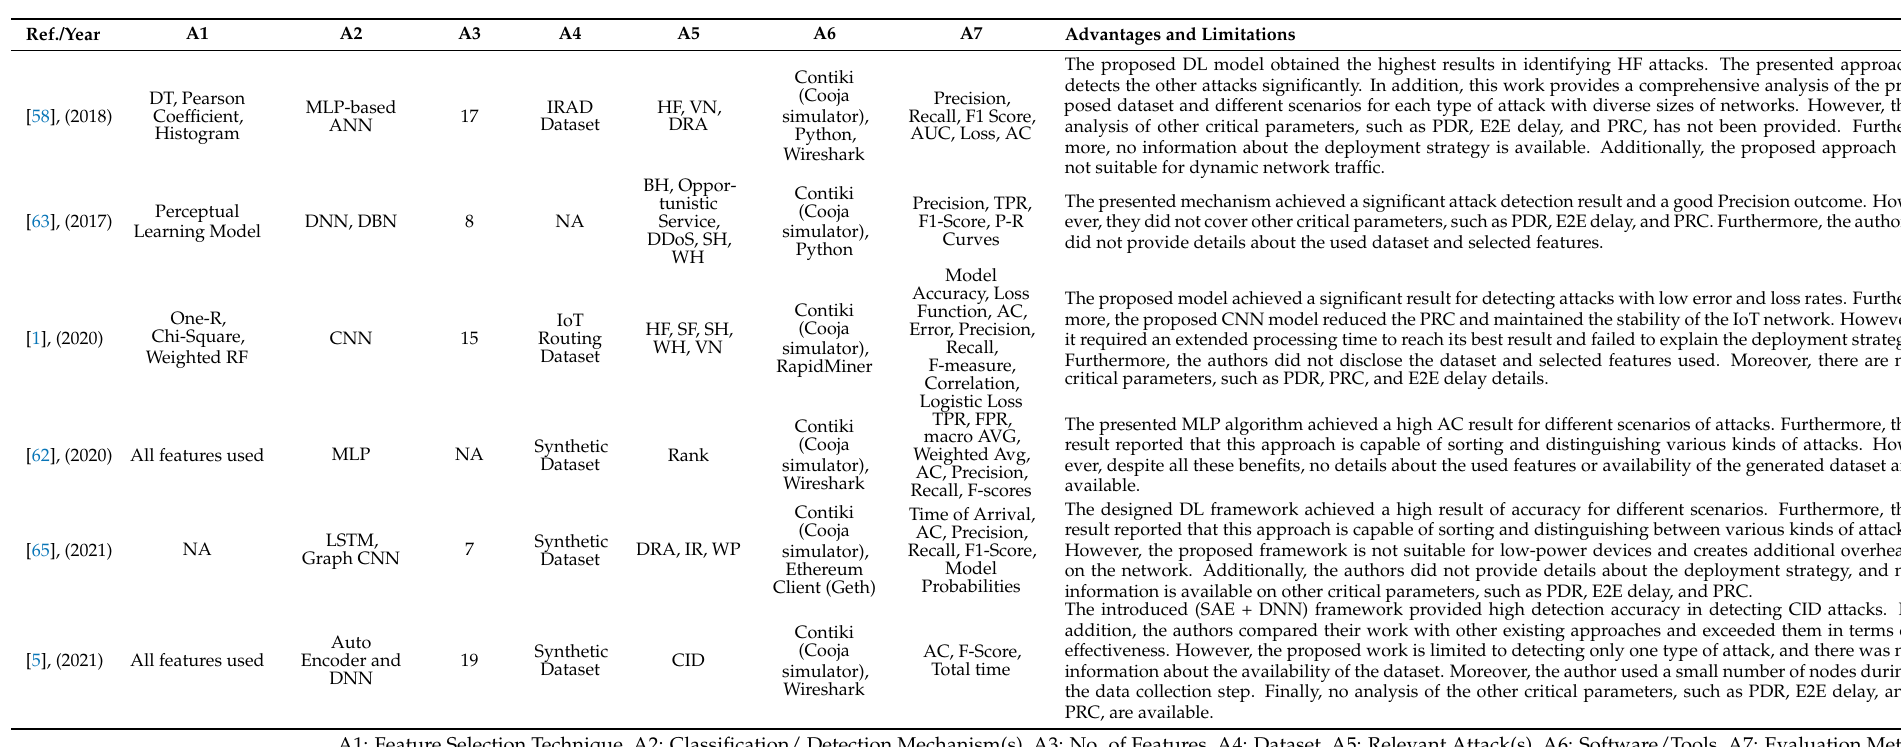
Table 3. Summary of deep learning-based